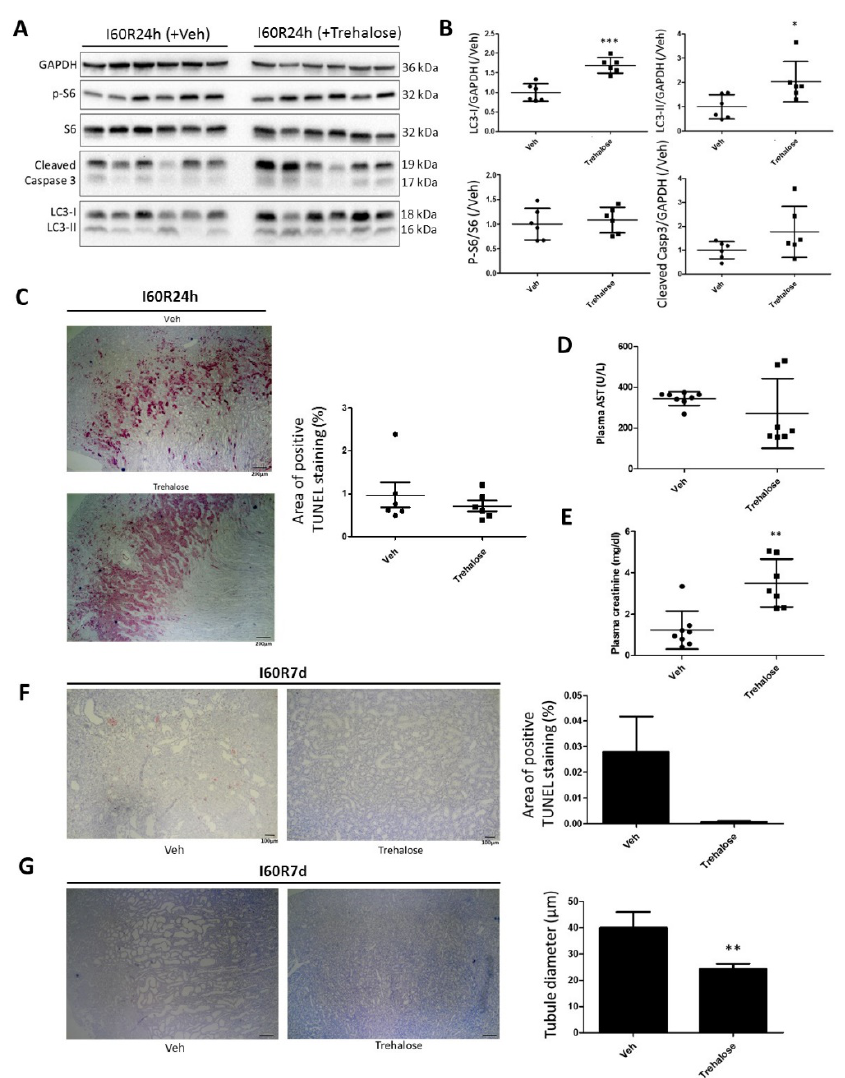
Figure 6. Trehalose induces autophagy and improves the renal structure post reperfusion following severe ischemia. Rats were injected with vehicle (Veh) or trehalose 48 h and 24 h prior to 60 min of renal ischemia (I60), and sacrificed 24 h (I60R24h) or 7 days (I60R7d) post reperfusion. Kidneys of I60R24h were analyzed by Western blotting for the annotated markers ( A ) and compared between Veh- and trehalose-treated for LC3-I, LC3-II, phosphorylated S6 (pS6), and cleaved caspase 3 ( B ). Kidney sections of I60R24h were also stained with TUNEL ( C ) and the plasma levels of AST ( D ) and creatinine ( E ) were determined. In the kidney sections of I60R7d, TUNEL staining was performed ( F ) and the average tubule diameter was assessed ( G ). * p < 0.05, ** p < 0.01, *** p < 0.001. N = 6.